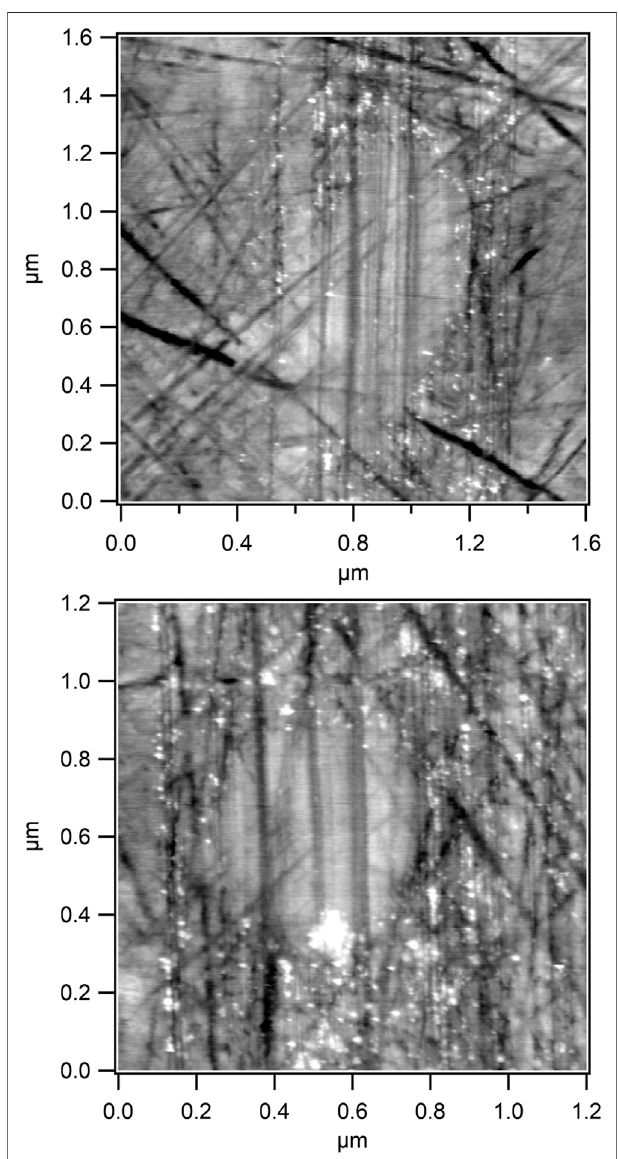
FIGURE6| Topographiesofworncarbides.The Z -scale ofboth images is ± 4 nm.